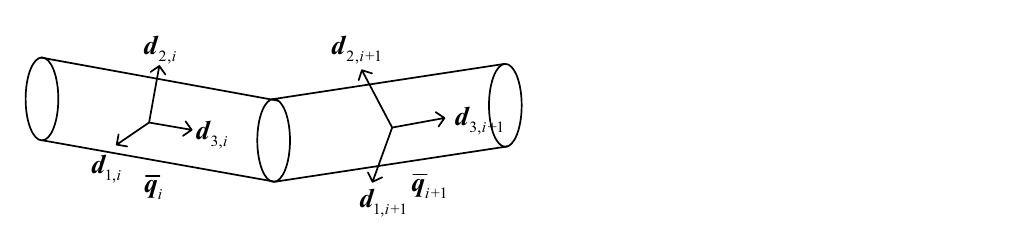
Figure 4. Torsion deformation between adjacent